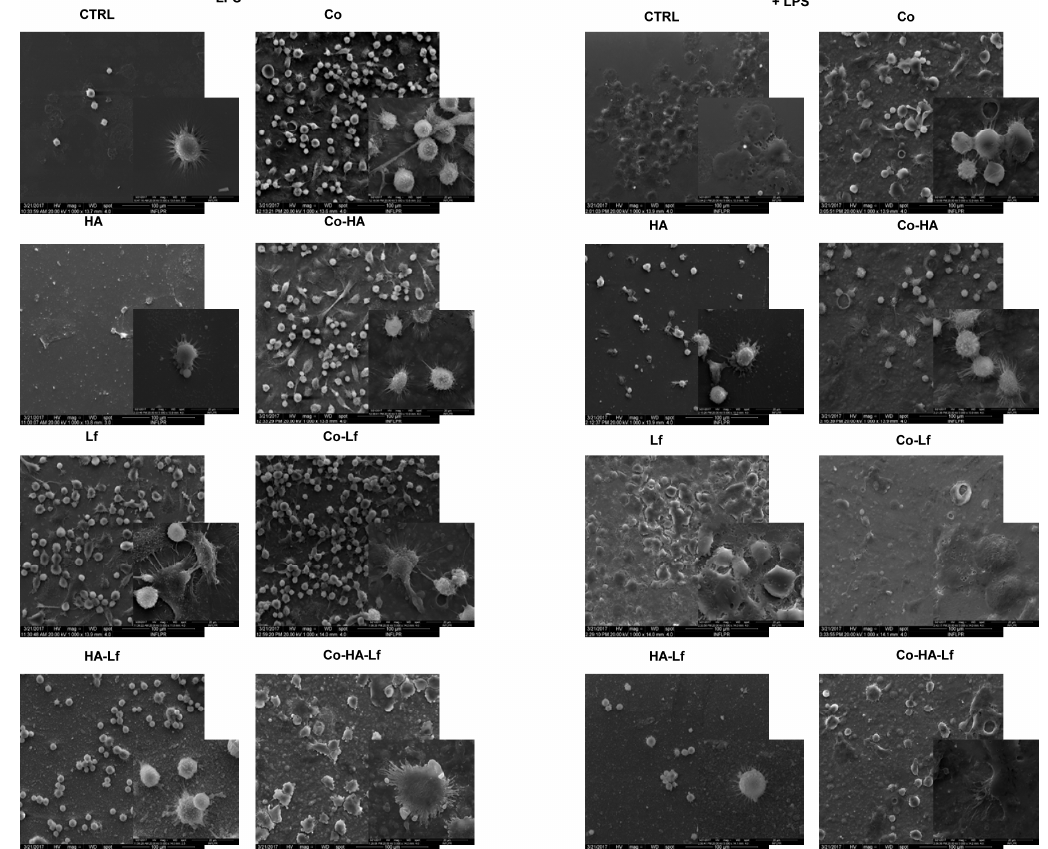
Figure 5. SEM images of THP-1-differentiated macrophages attached to the surface of biomimetically modified surfaces in the absence and presence of bacterial endotoxin. Scale bar 100 μ m for 1000× images and 20 μ m for the inserted image with 5000× magnification order. HA: hydroxyapatite; Lf: